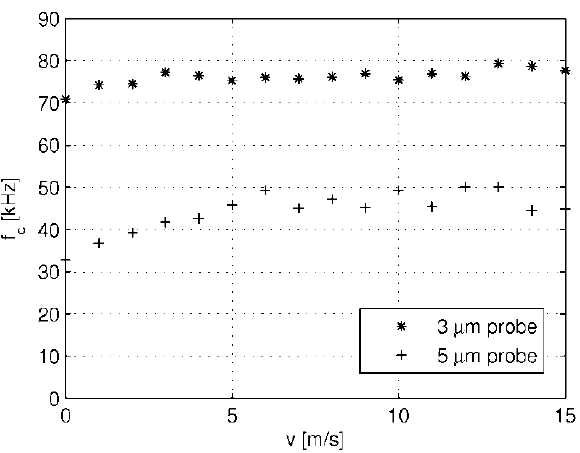
Figure 10. The bandwidth frequency in the function of flow velocity for measurement probes with 3 and 5 µm wires.